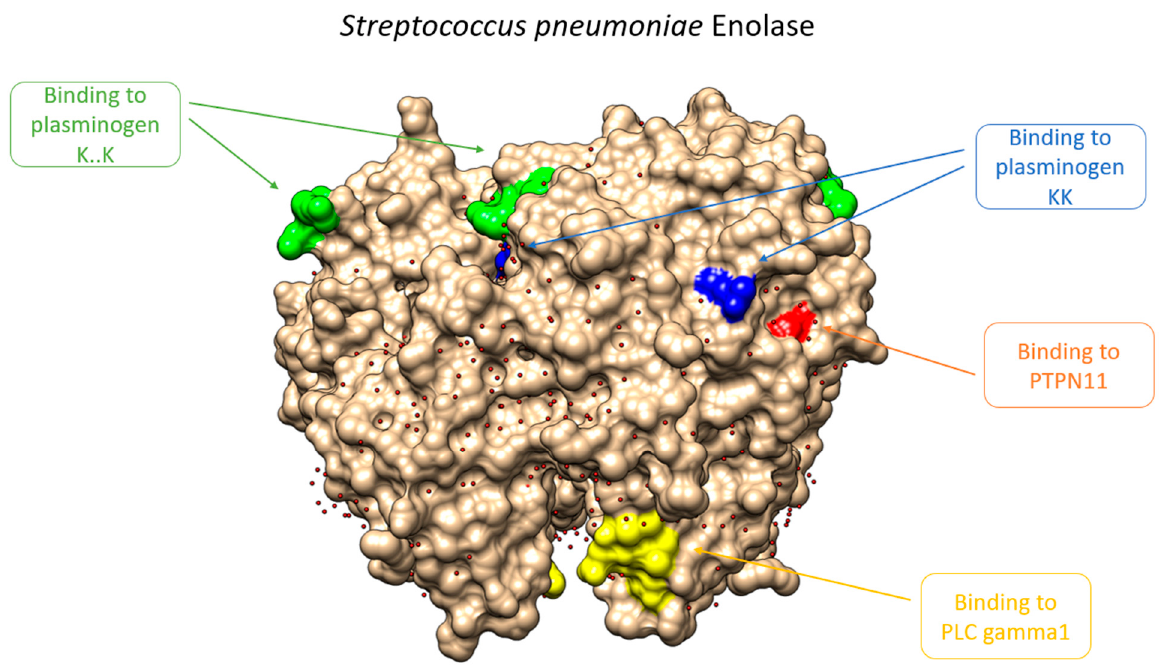
Figure 2. Structural view of Streptococcus pneumoniae enolase showing different PLG binding motifs. In green and blue are the plasminogen binding motifs described in the bibliography. In yellow and red are the bioinformatically predicted motifs that are related to virulence or immunoediting process. More information about these motifs can be founf in Table 1. W6T.